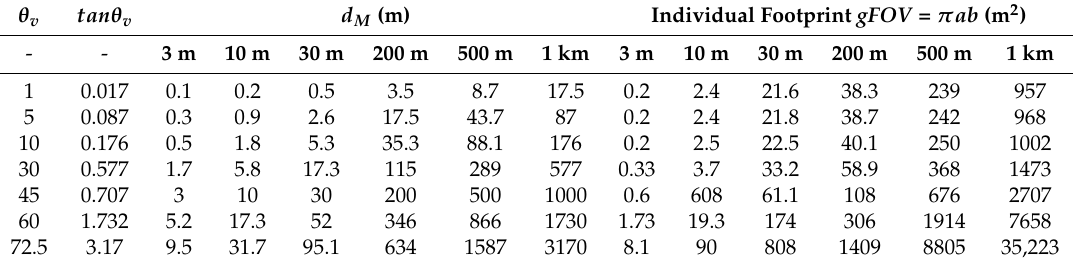
Table 4. Distance d M , between the optical axes and local vertical intercepts with the ground surface. Values are given for increasing viewing zenith angles θ v and installation heights h (in bold). The second part of the table gives the gFOV elliptical area for the same observing conditions. For h of 3, 10 and 30 m the instrument field-of-view f is assumed to be 5 ◦ to mimic PARABOLA, while for h > = 200, f is set to 1 ◦ to mimic